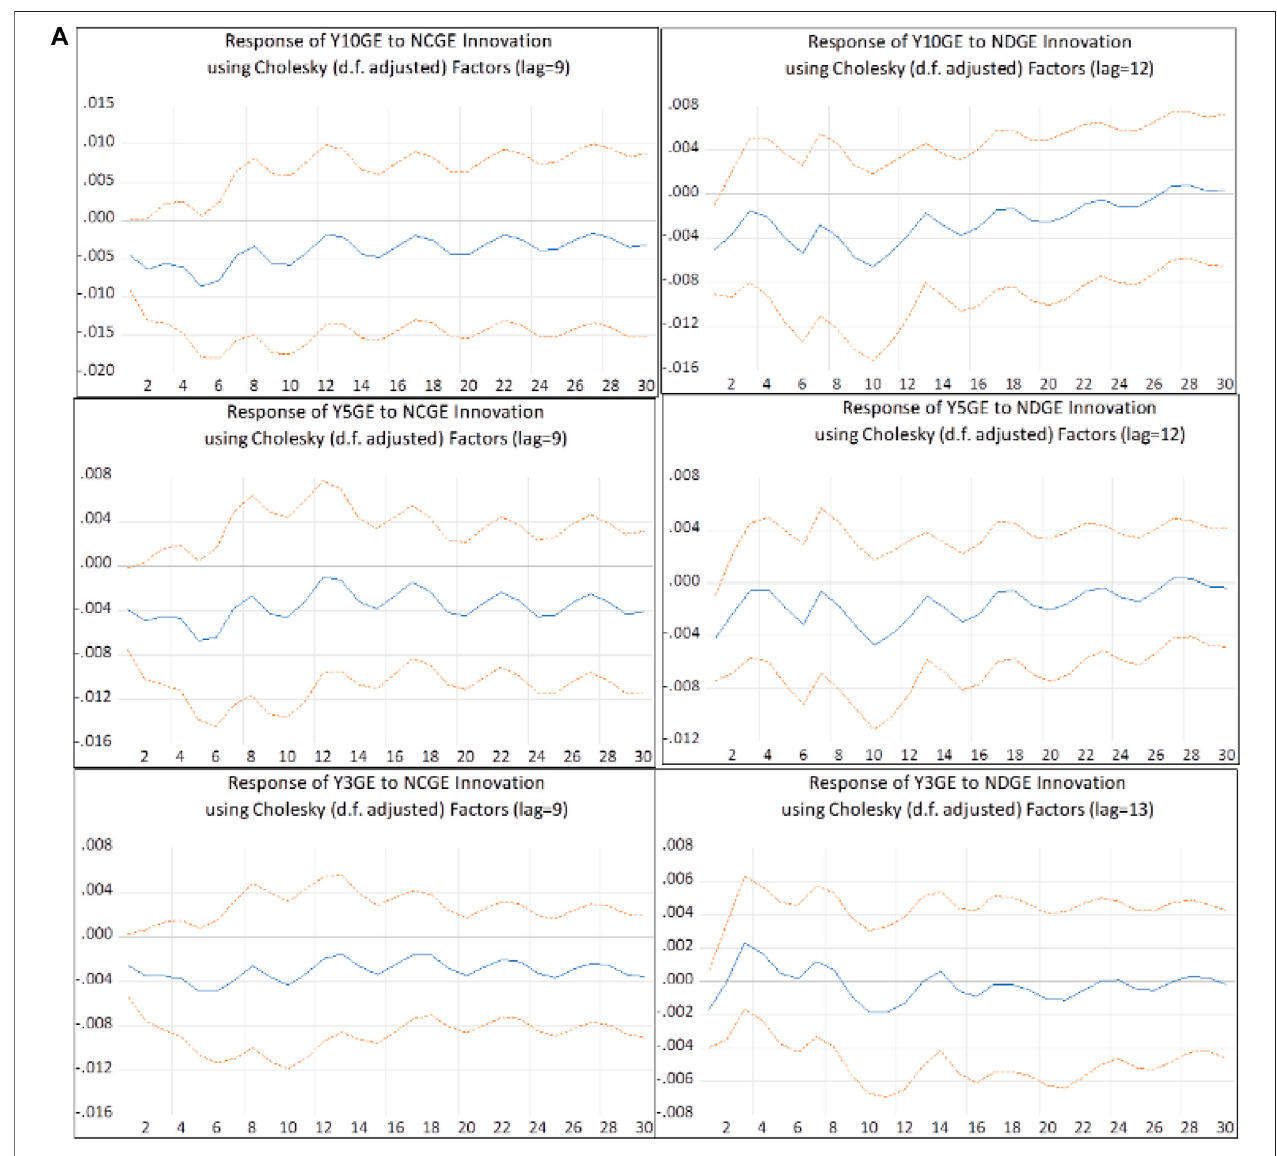
FIGURE4| ResponseofGermangovernmentbondyieldstothespreadoftheCOVID-19pandemicinthecountryandgloballevel.Note:Theeffectofthecountry- level COVID-19 situation can be seen in (A) , while the effect of the global level situation is shown in (B) .